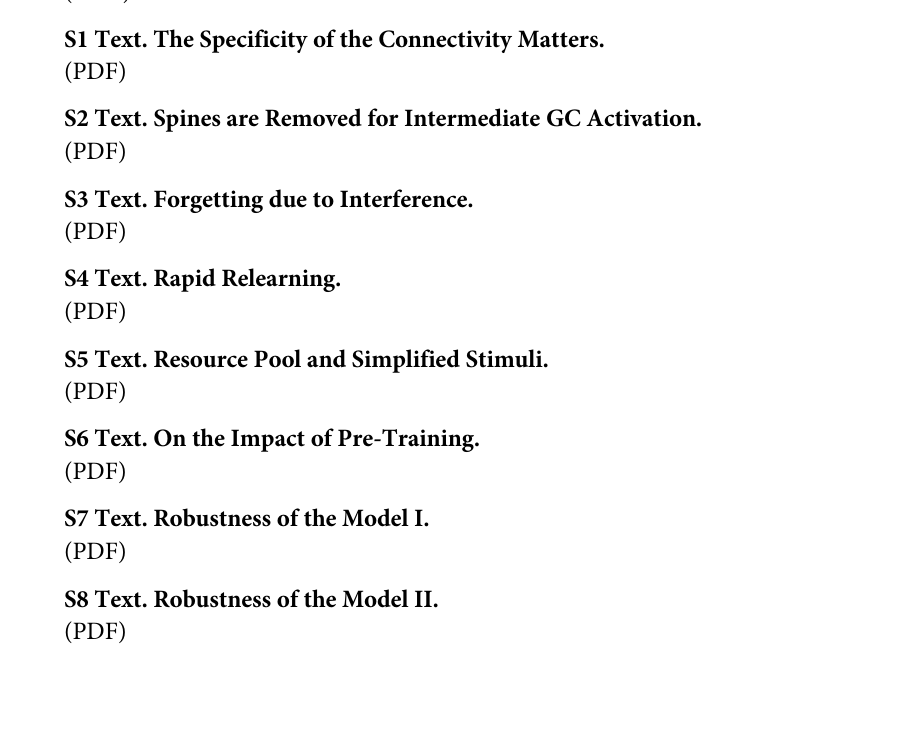
S14 Fig. Qualitatively, the results for the fraction of responsive and divergent cells do not depend on the threshold θ for their classification. (A, B) Training with naturalistic stimuli for different thresholds θ . The results in Figs 2 and 9 are based on θ = 0.2. (C, D) as (A, B) but for training with simplified stimuli. (E, F) as (A, B) but in the resource-pool model. (TIFF) S1 Text. The Specificity of the Connectivity